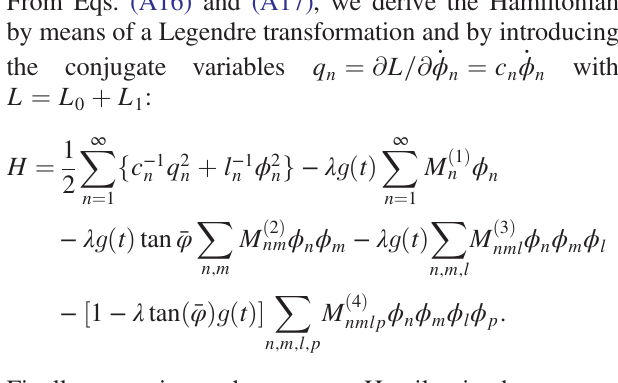
ffiffiffiffiffiffiffiffiffiffiffiffiffiffiffi ω c = 2 n n